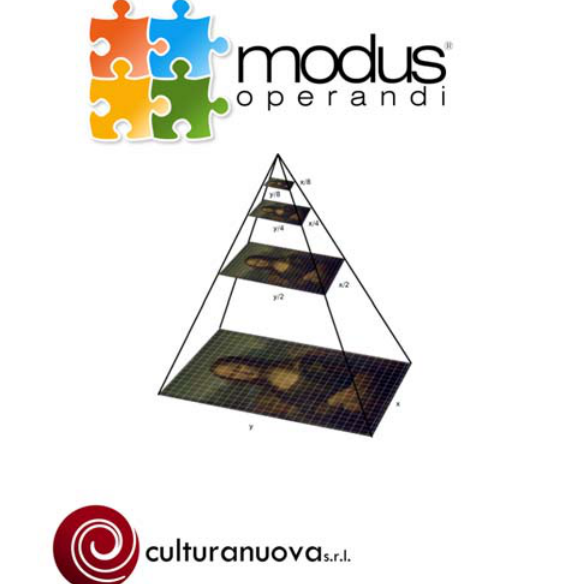
Figure 4. Modus Explorer is a utility for Modus Operandi, management system produced by Cultura Nuova